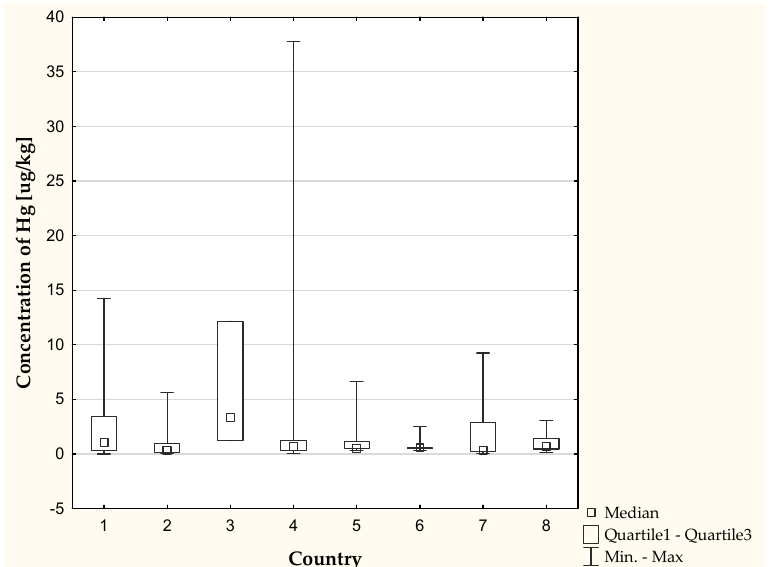
Figure 3. Concentration of Hg depending on the country of origin of the cosmetic ( p < 0.05). 1: France; 2: Germany; 3: Korea; 4: Poland; 5: Russia; 6: UK; 7: USA; 8: Other.